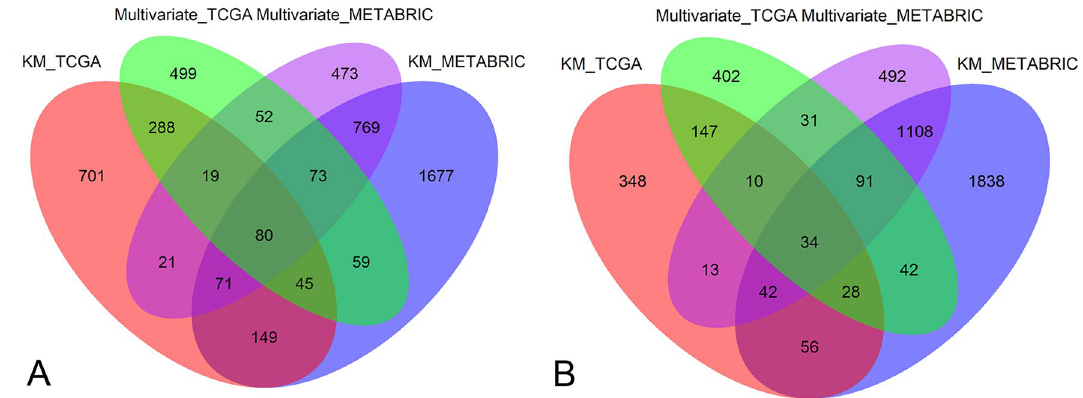
Figure 1. The prognosis-related genes common to the TCGA and METABRIC datasets. ( A ) The protective prognostic genes common to the TCGA and METABRIC datasets. ( B ) The risk prognostic genes common to the TCGA and METABRIC datasets. KM_TCGA and multivariate_TCGA represent prognosis-related genes determined by the Kaplan–Meier survival analysis and multivariate Cox regression analysis respectively in the TCGA cohort. Similarly, KM_METABRIC and multivariate_METABRIC denote survival-related genes in the METABRIC